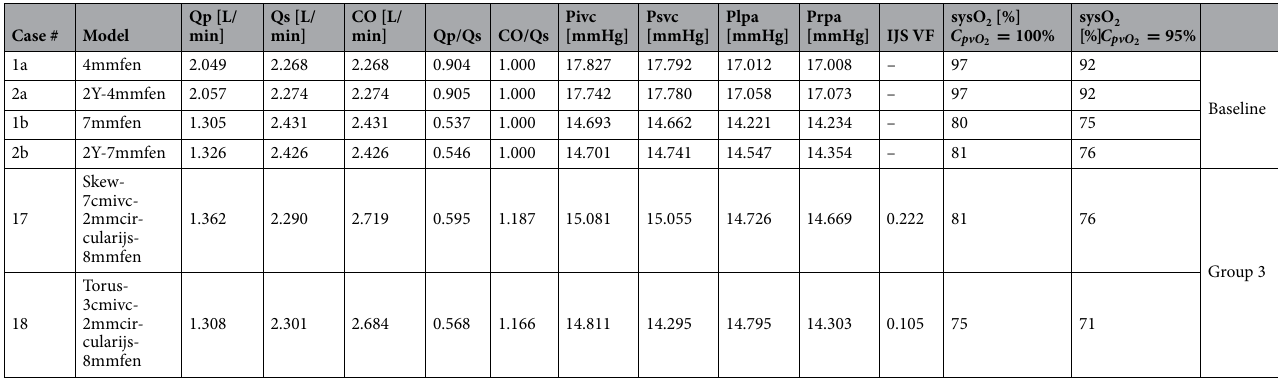
Table 3. Summary table of best IJS and fenestration size and placement implemented in modified Fontan conduit topology (Model nomenclature: [anatomic variant] − [distance between IJS nozzle and cavopulmonary connection] − [IJS diameter] – [fenestration diameter]).